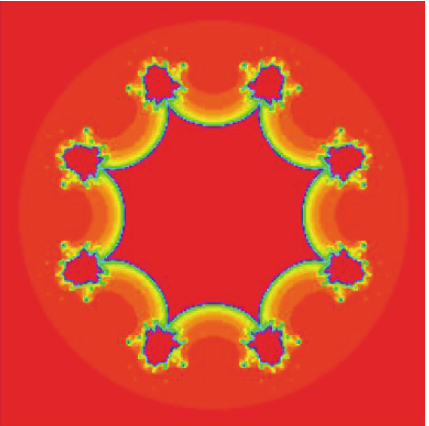
Figure 17: Relative superior multicorn for 𝑠 = 0.7 and 𝑠 󸀠 = 0.4 .